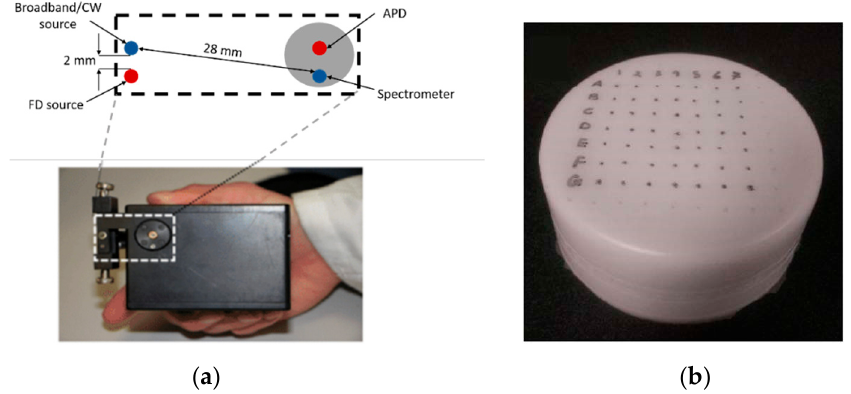
Figure 5. ( a ) DOS (Diffuse Optical Spectroscopic) handheld imaging probe geometry. ( b ) Rectangular grid measurement pattern on phantom (7 cm × 7 cm).